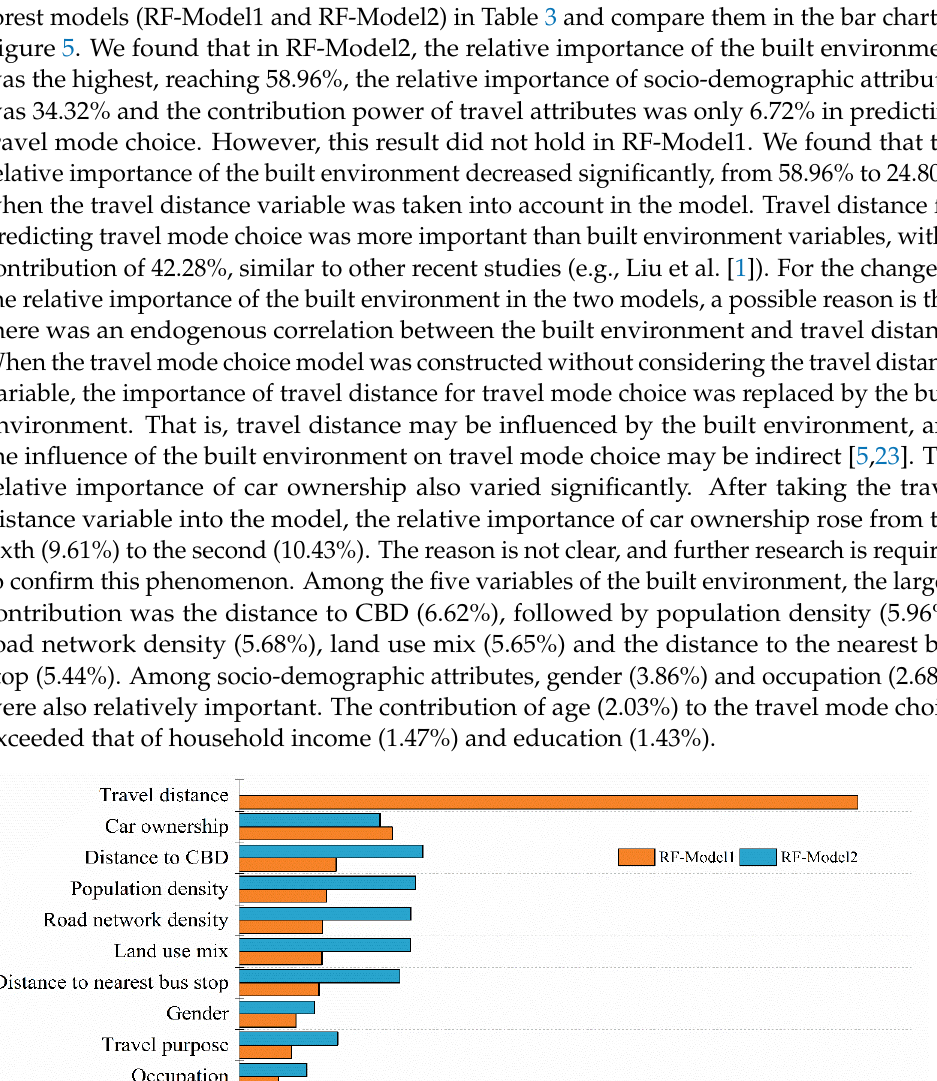
Table 3. Relative importance of feature variables (RF-Model1/RF-Model2).